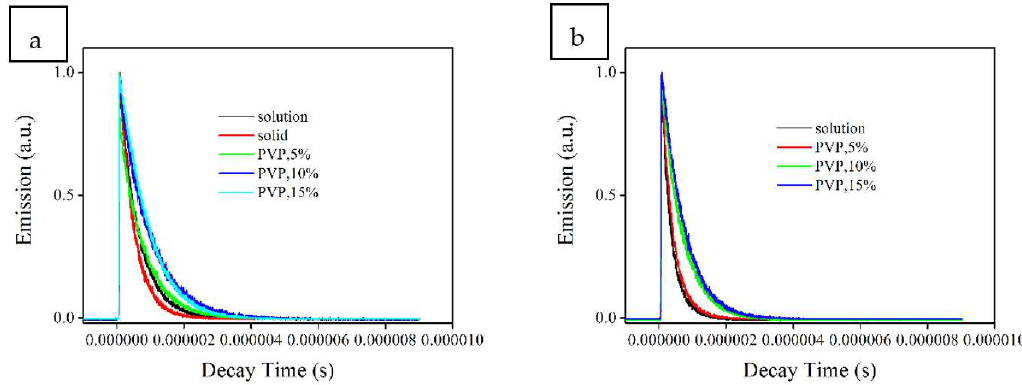
Figure 5. Emission decay dynamics of Ir(ppy) 2 (BPE) ( a ) and Ir(ppy) 2 (TPP) ( b ) in CH 2 Cl 2 solution (1 μM), in the solid state and in PVP fiber (5%, 10% and 15%).